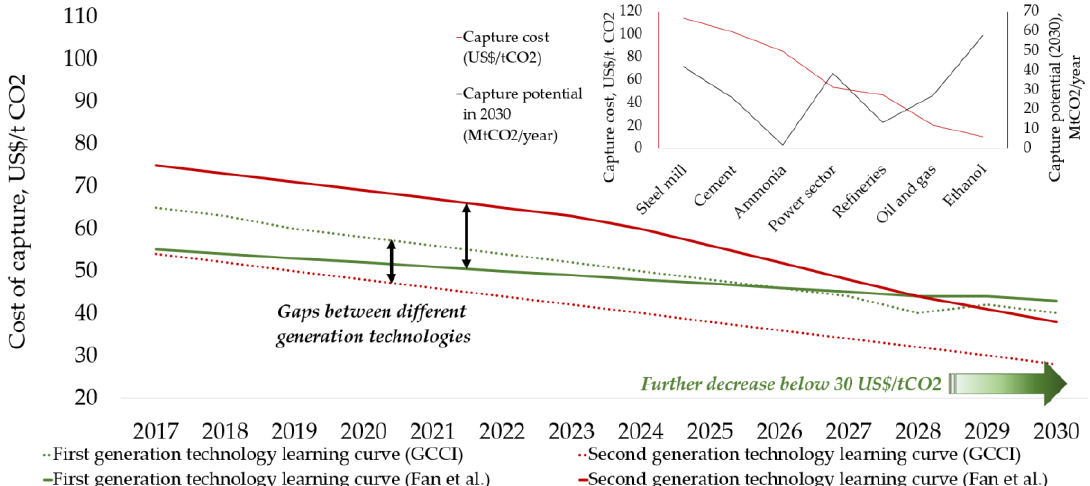
Figure 10. Learning curves of capture technologies. Based on [121–125].